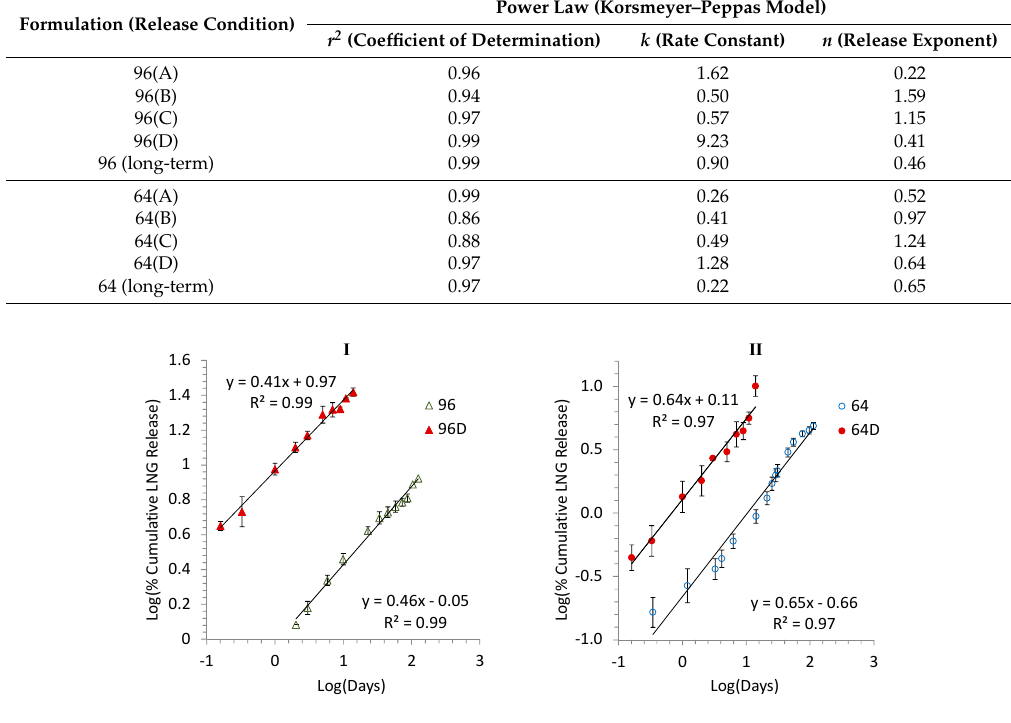
Figure 3. Power law kinetics (plot of log percent release vs. log of time in days) of formulations 96 ( I ; triangle) and 64 ( II ; circle) in real-time (open symbols) and accelerated (filled symbols) release condition D.